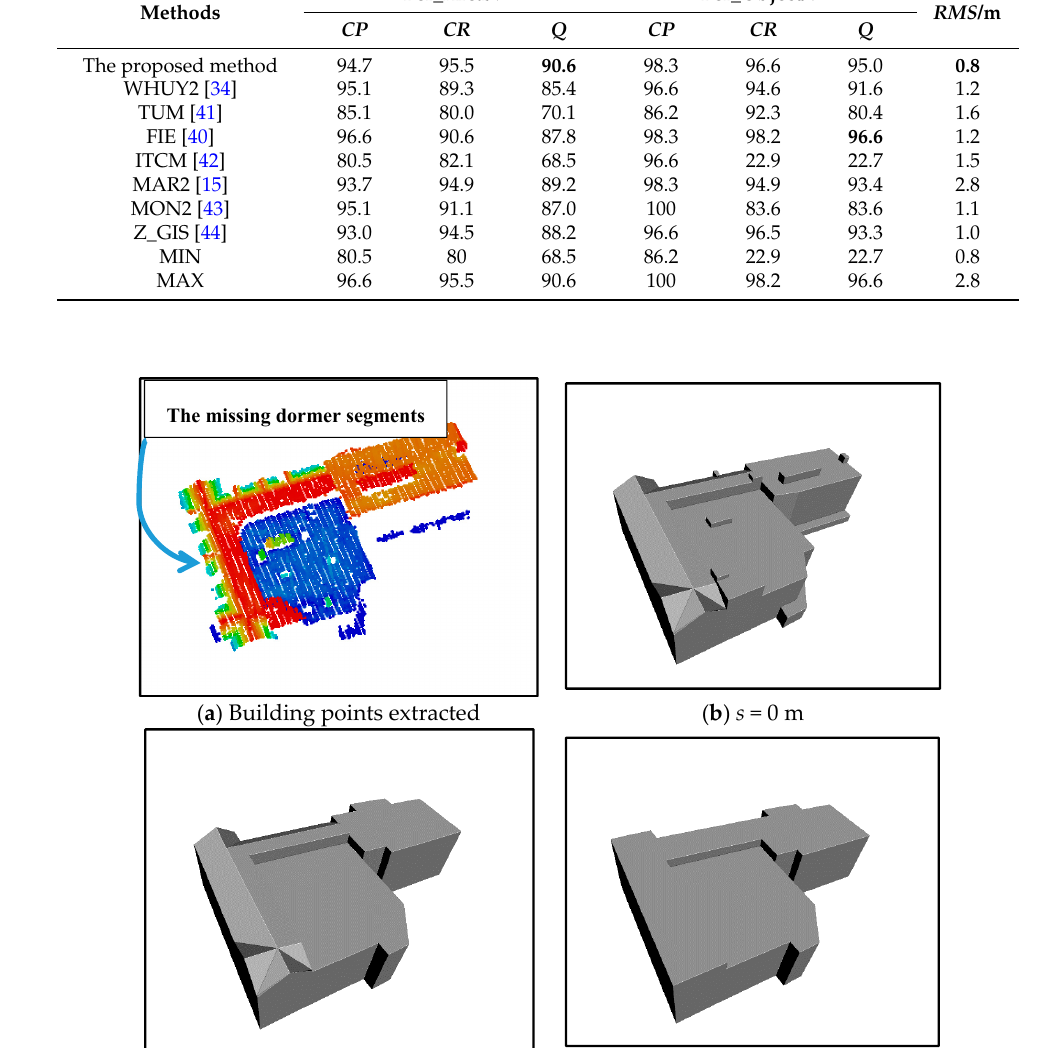
Table 5. Evaluation result by ISPRS; the best results are highlighted.